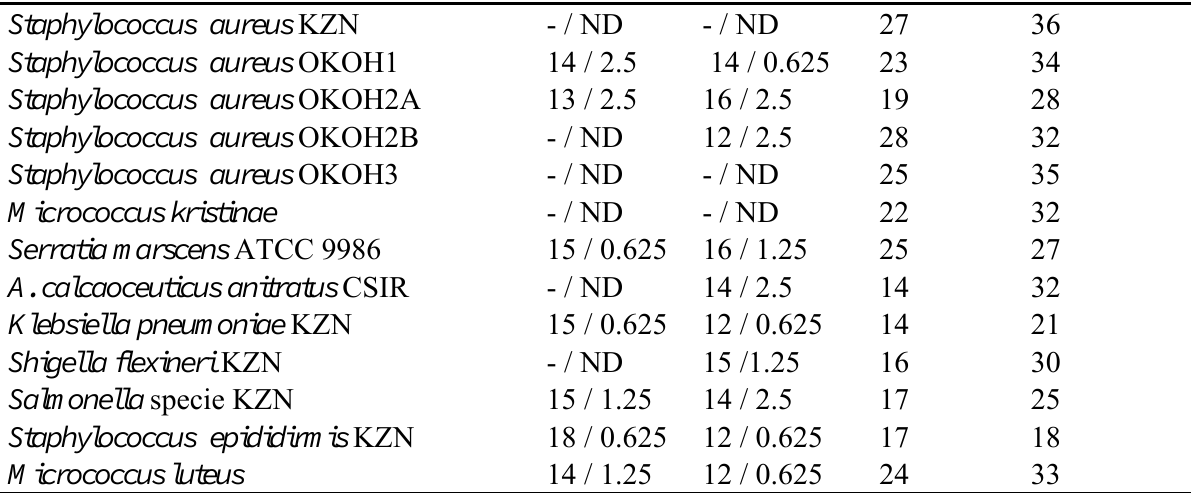
Key: - represents no antibacterial activity; MIC represents minimum inhibitory concentration; ND represents not determined. Table 2. Antivibriol activities of crude aqueous and n-hexane extracts of C . nucifera husk on Vibrio